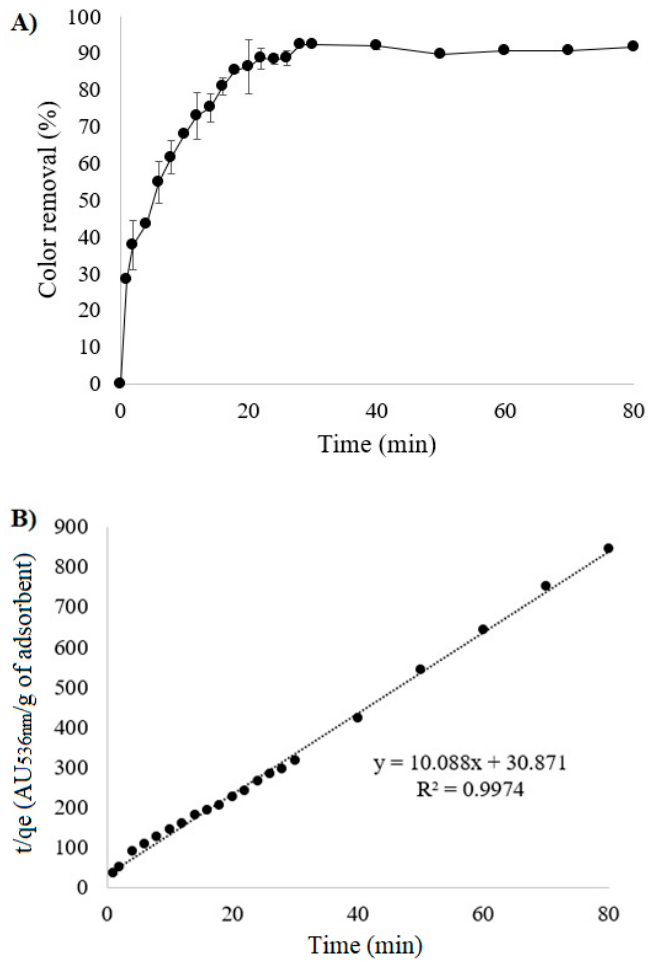
Figure 3. ( A ) Dye removal percentage and ( B ) dye adsorption kinetics from TW by orange seed (OS) powder bio-adsorbent in a 10 L reactor.